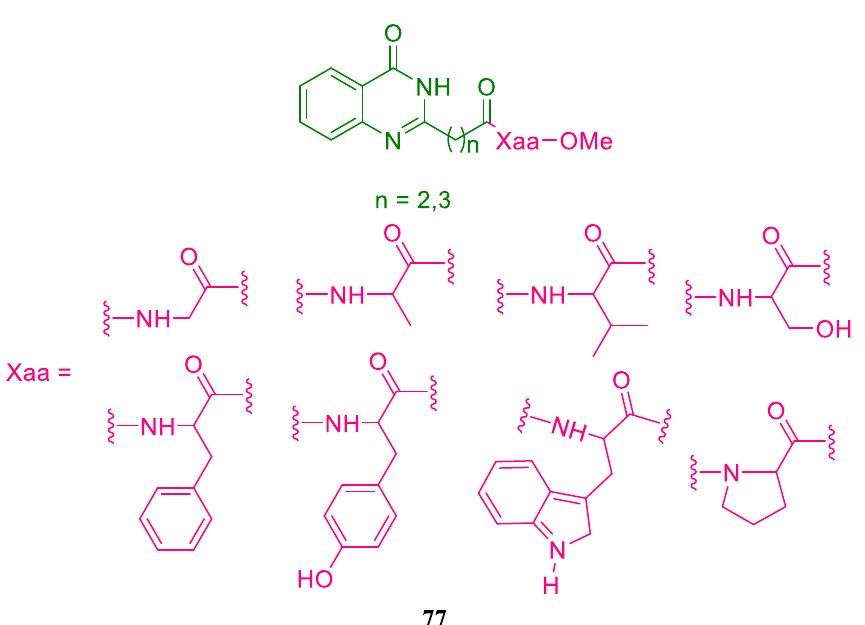
Figure 63. Amino acids linked quinazolinones.